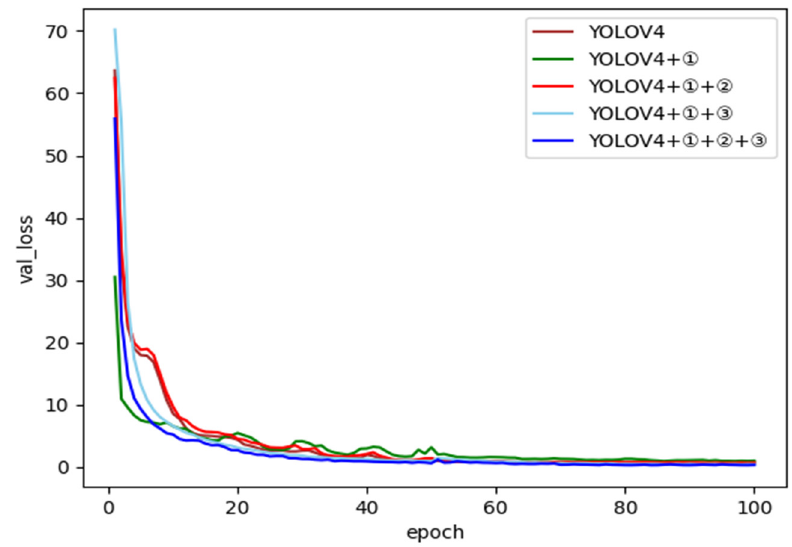
Figure 8. Loss curve of each model test